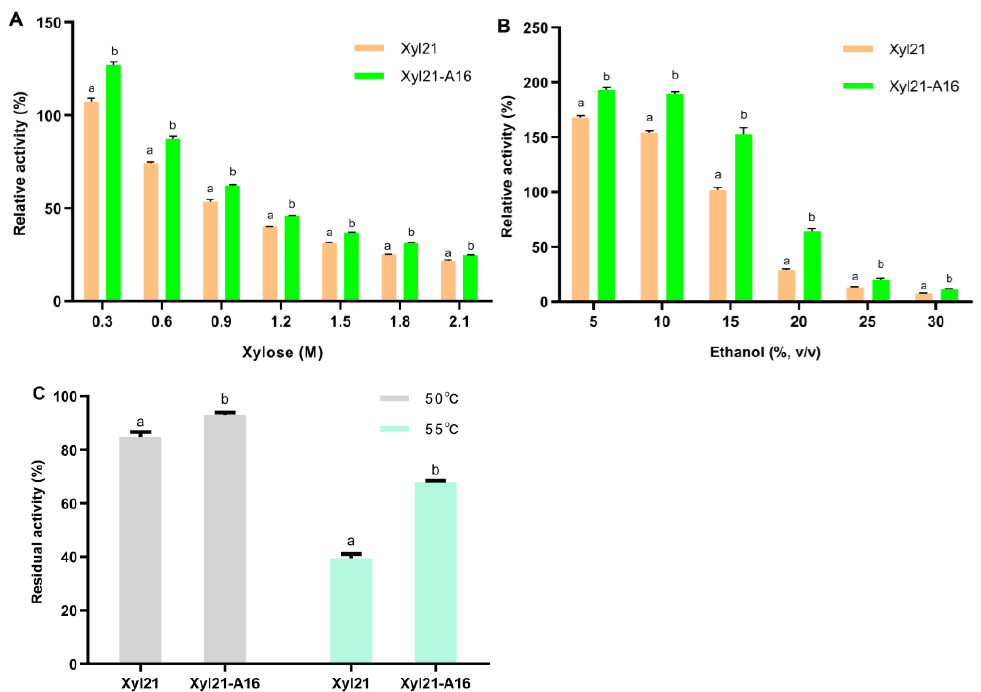
Figure 5. The xylose tolerance ( A ), ethanol tolerance ( B ), and thermostability ( C ) of mutant Xyl21-A16 compared to the wild type Xyl21. Results are expressed as means of three replicates and standard errors. Means with the same letters are not significantly different ( p > 0.05, evaluated by t -test).